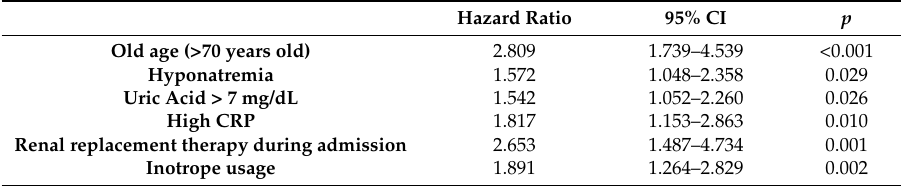
Table 5. Independent predictors of post-discharge 1-month mortality. CRP, C-reactive